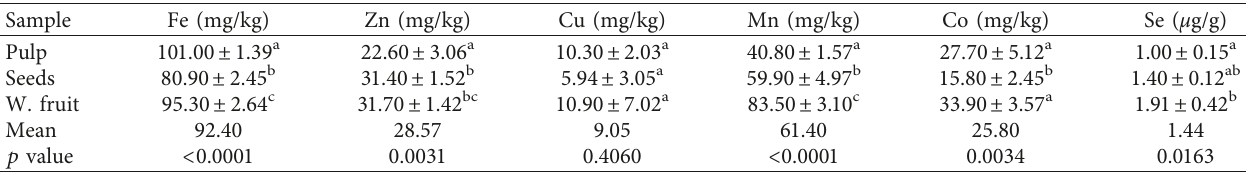
Table 3: HCl-extractable trace elements composition in the fruit of Tetrapleura tetraptera